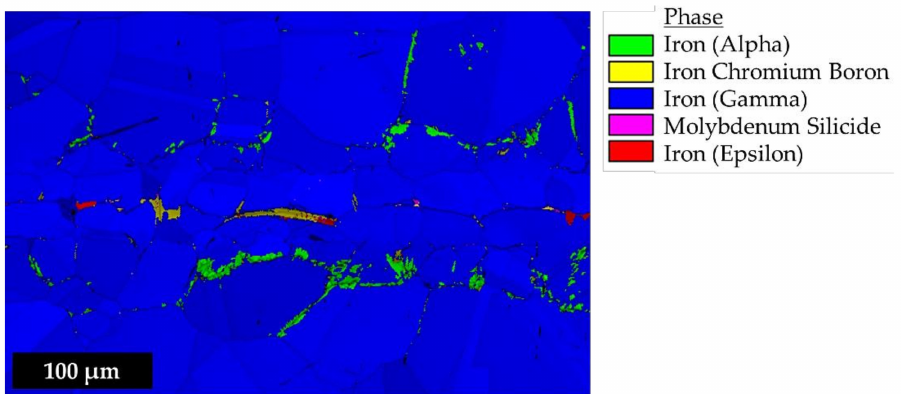
Figure 10. Electron backscatter diffraction (EBSD) phase analysis of ST20 15min.